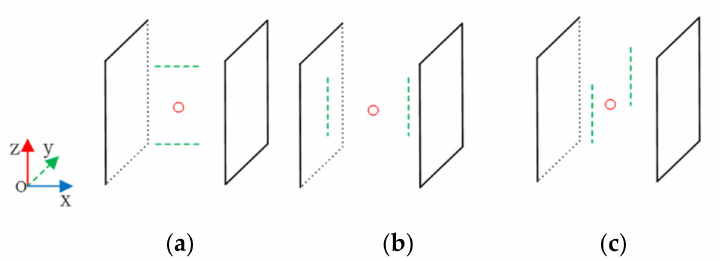
Figure 4. ( a ) The line obstacle is in the orthogonal directions of z -axis. ( b ) The line obstacle is in the orthogonal directions of x -axis. ( c ) The line obstacle is in the orthogonal directions of y -axis.